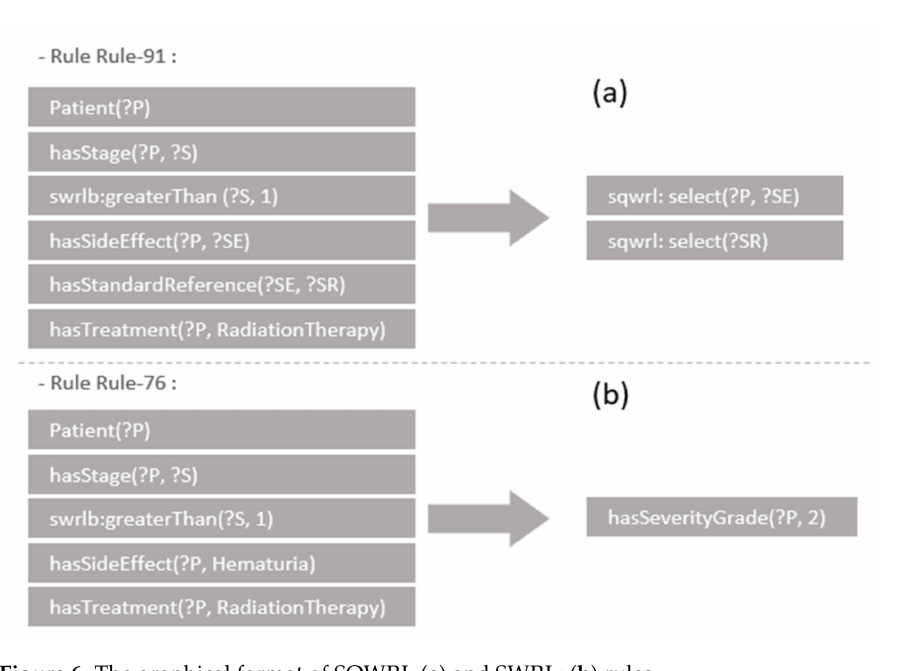
Figure 6. The graphical format of SQWRL ( a ) and SWRL; ( b )